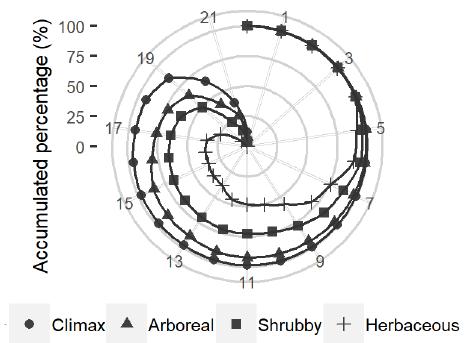
Figure 3. Accumulated percentage of the potential distribution area of the 22 species within the current Tropical Rainforest area.